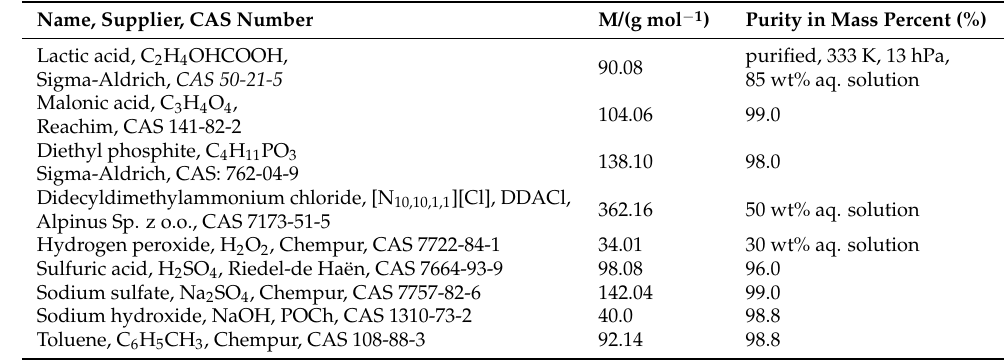
Table 6. Data on the chemicals used: name, supplier, CAS number, molecular mass (M), mass fraction purity (as stated by the